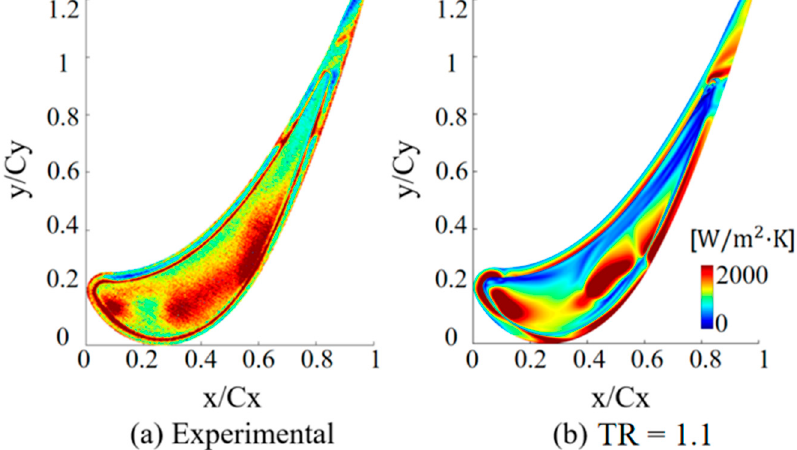
Figure 3. Comparisons of the HTC distribution of an uncooled squealer tip between ( a ) experimental results and ( b ) CFD results at TR = 1.1.